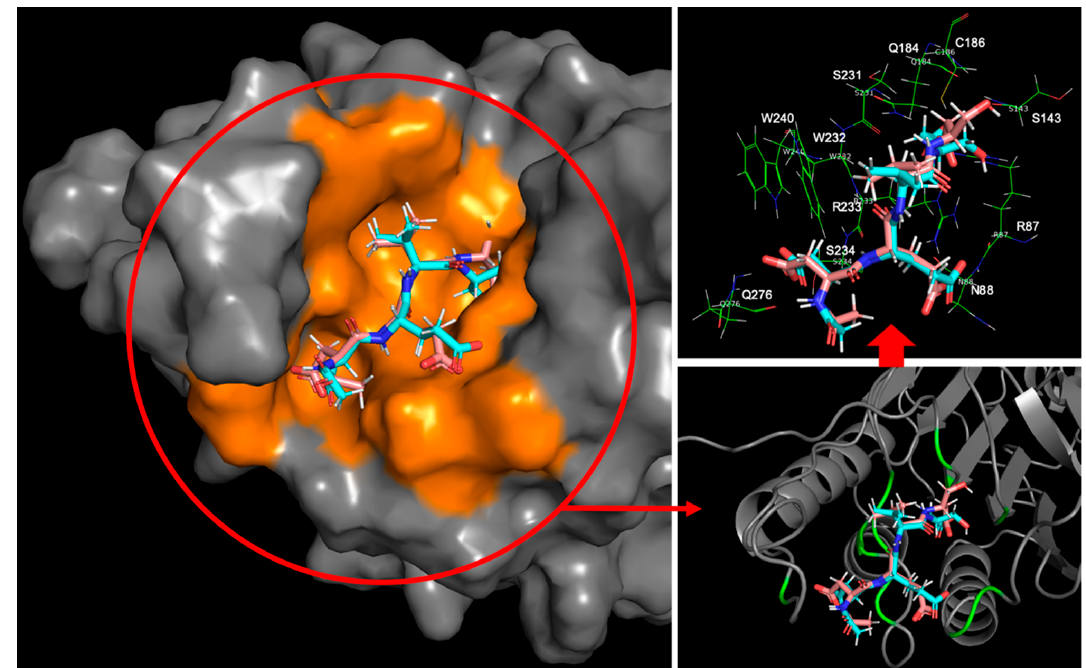
Figure 8. The global minimum docked pose (cyan) together with the crystal ligand conformation (pink) for Ac-DEVD-Cho bound to caspase-7. The orange surface on the left shows the area of interaction interface at the caspase-7 binding site. The green ribbon on the bottom right shows the locations of the residues having close contact (within 3 Å) with the global minimum docked pose. All residues having close contact with the global minimum Ac-DEVD-Cho pose are shown in the picture on the top right.